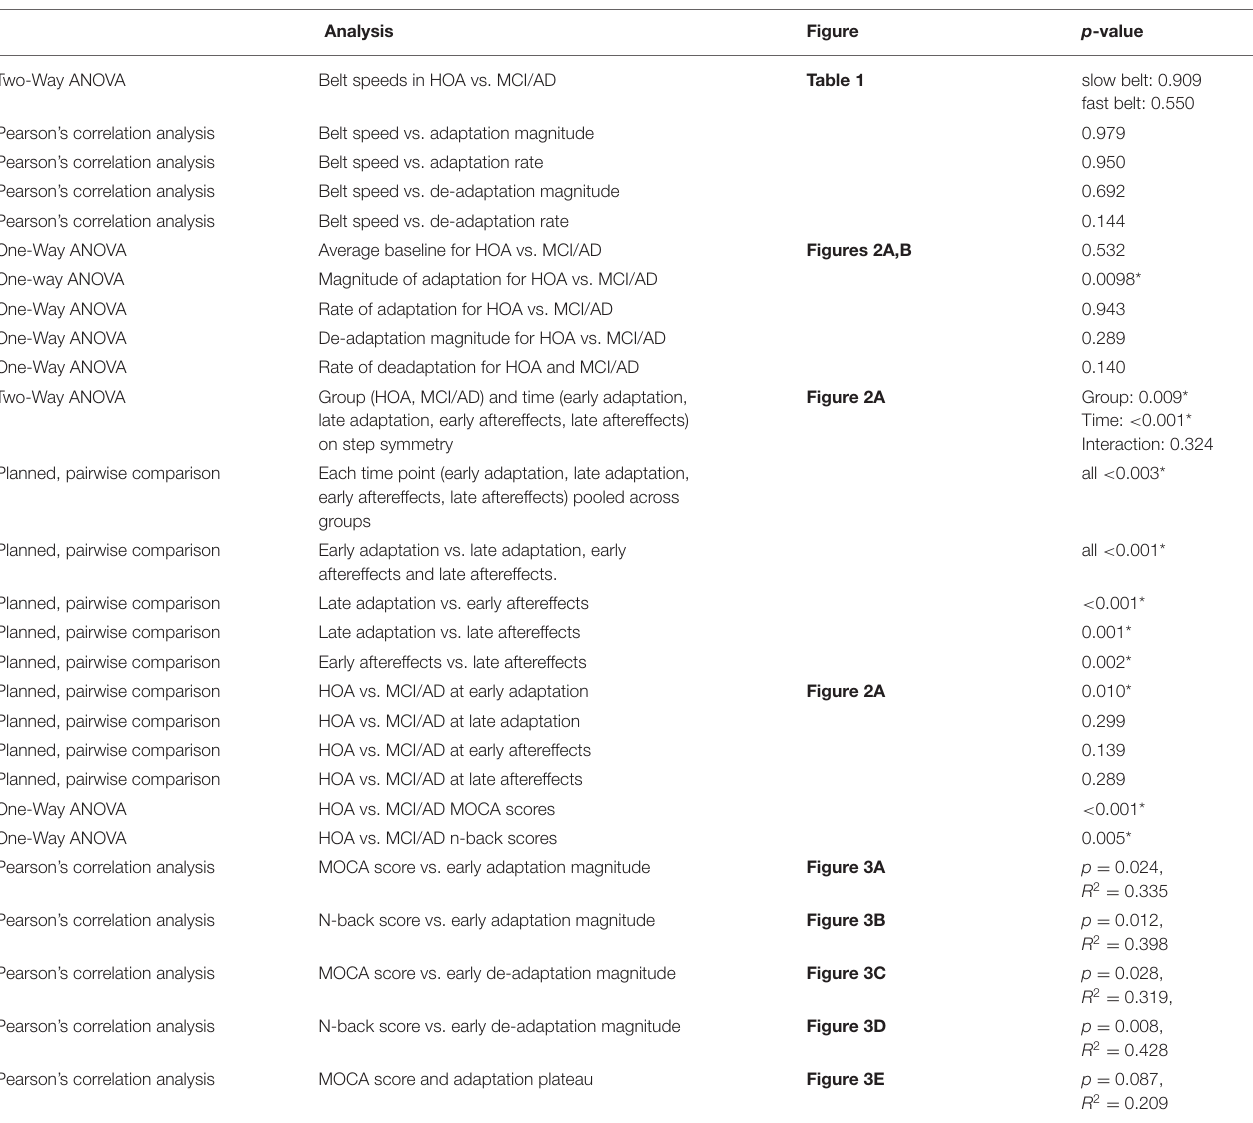
TABLE 2 | Statistical results. Analysis Figure p -value